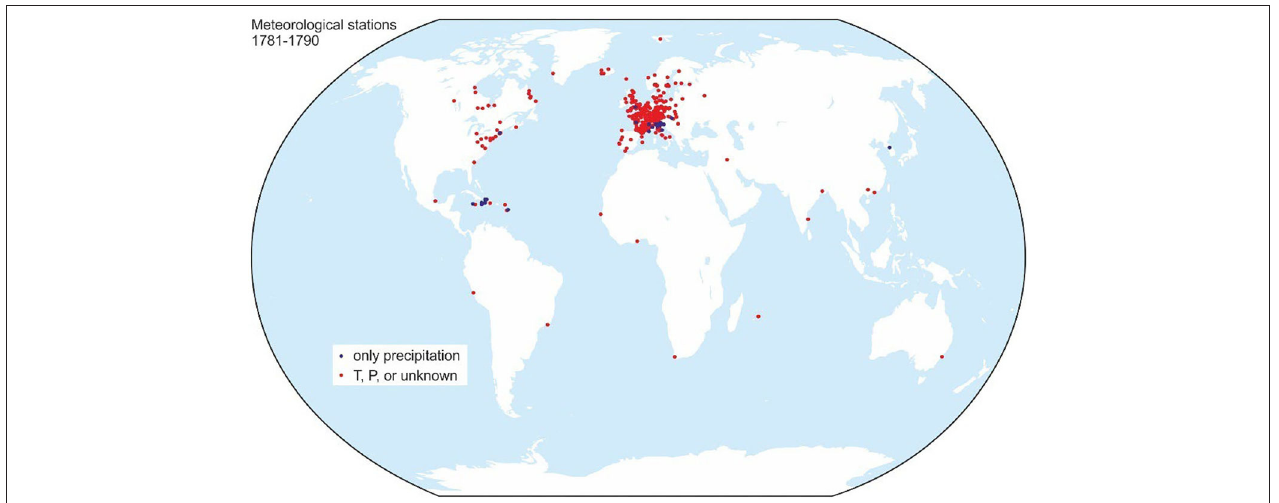
FIGURE 1 | Global map of meteorological stations in the decade 1781–1790, irrespective of whether the data are digitally available, imaged, or whether the location of the hard copies is even known.